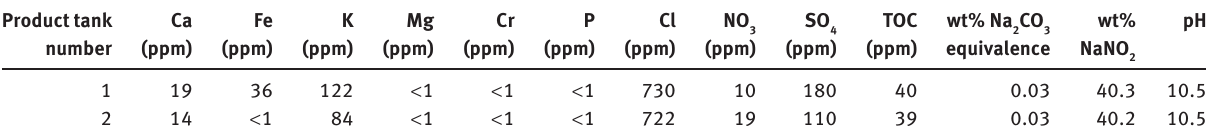
Table 6 Product analyses from the second carbon purification campaign of contaminated 40 wt% NaNO